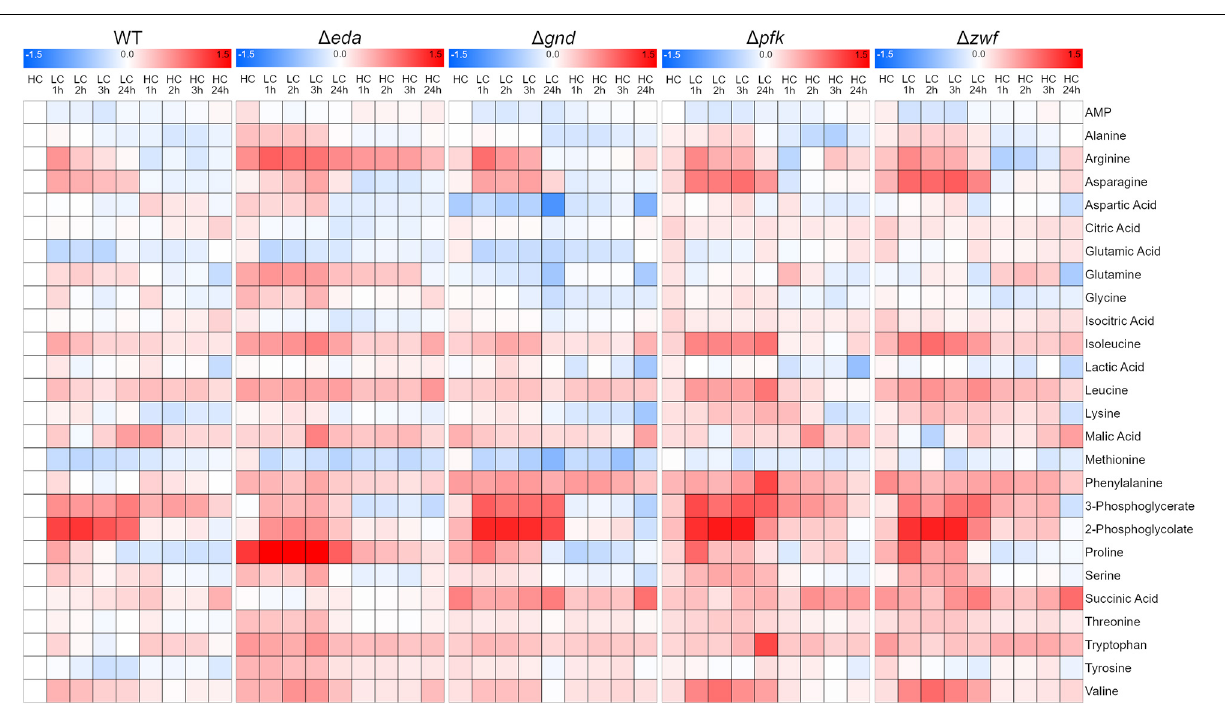
FIGURE 3 | Heat maps displaying the metabolic changes in different strains during HC-LC-HC shifts. The relative changes in the amounts of 26 metabolites are shown. The metabolite level in wild-type cells (WT) in the initial HC phase was set to one. All other metabolite values in the different strains at each sampling point are shown as fold changes (log 10 values) related to HC value in WT cells (red – increases, blue – decreases) ( n =